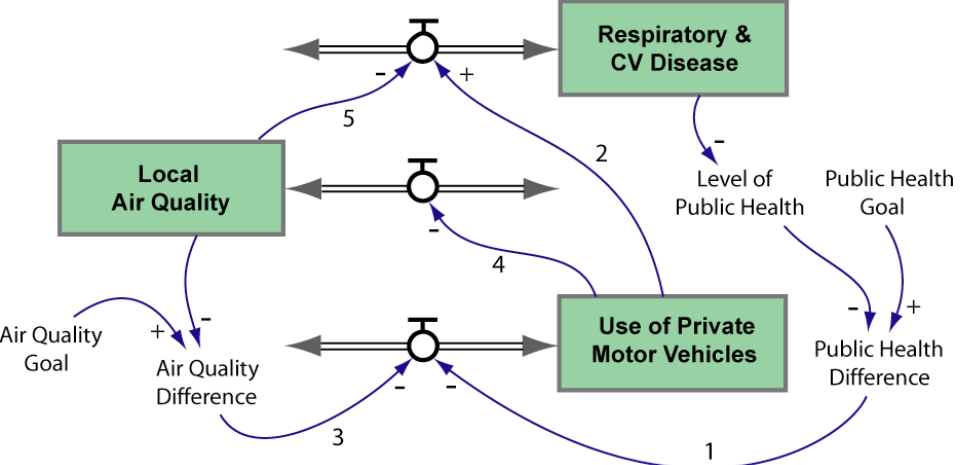
Figure 7. A stock-and-flow version of the co-effects structure of Figure 6. The graphical conventions are those defined for Figure 1. The double-lined, double-ended arrows are “bi-flows” representing net processes that can drive the levels of their affected stocks up (inflow) or down (outflow). The variables labelled Public Health Difference and Air Quality Difference represent the difference between the actual level of the controlled variables and their respective goals.